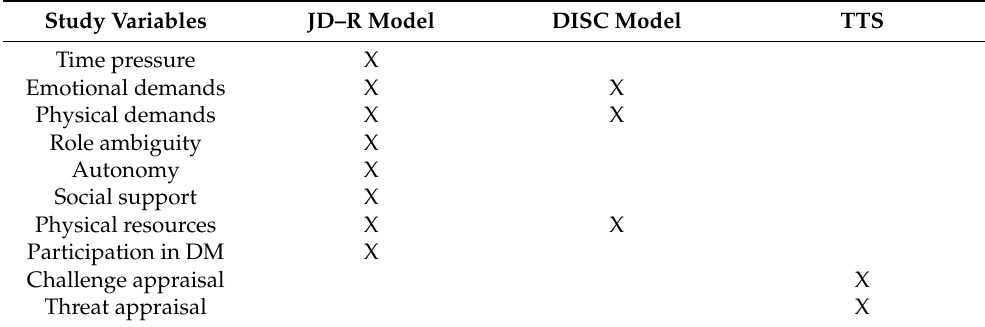
Table 1. Overview of the connections between studied variables and theoretical